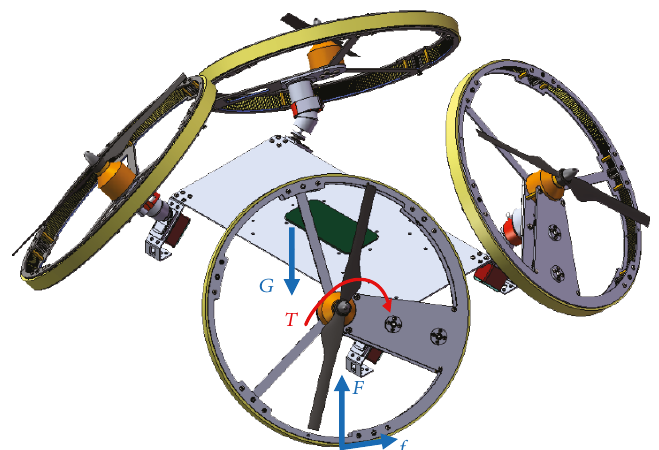
Figure 9: Force analysis of the transformable process.